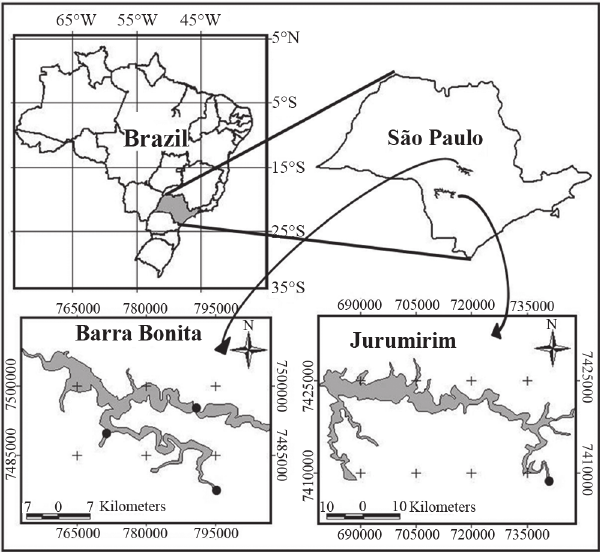
Fig. 1. Location of the Barra Bonita Reservoir and the Jurumirim Reservoir with sampling sites (black circles).